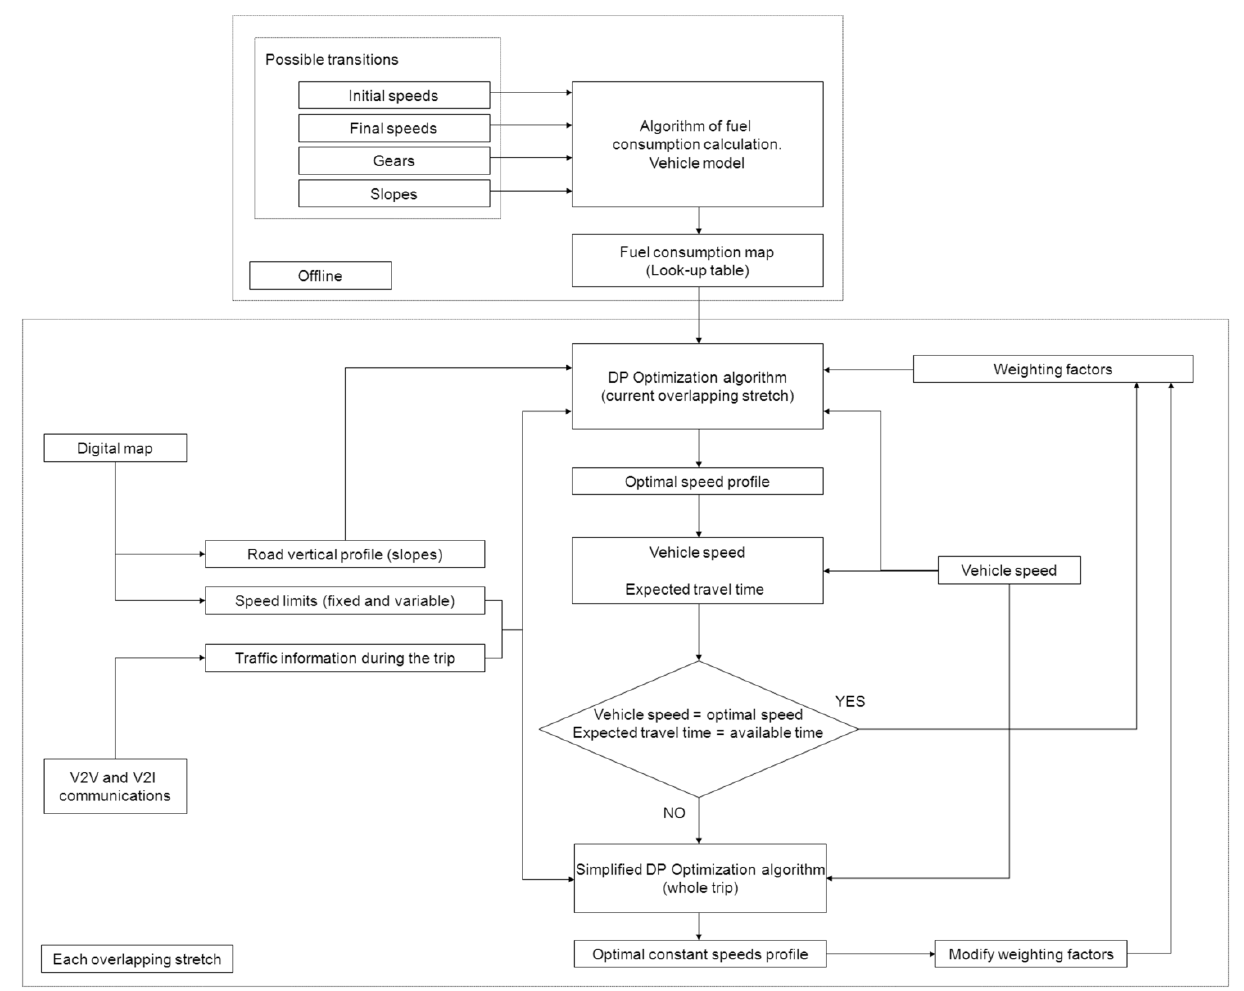
Figure 1. Scheme of the optimization